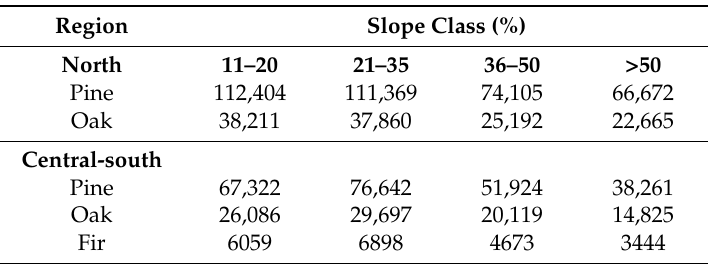
Table 3. Technically available woody biomass from non-extracted stands constrained by slope percentage (m 3 ).